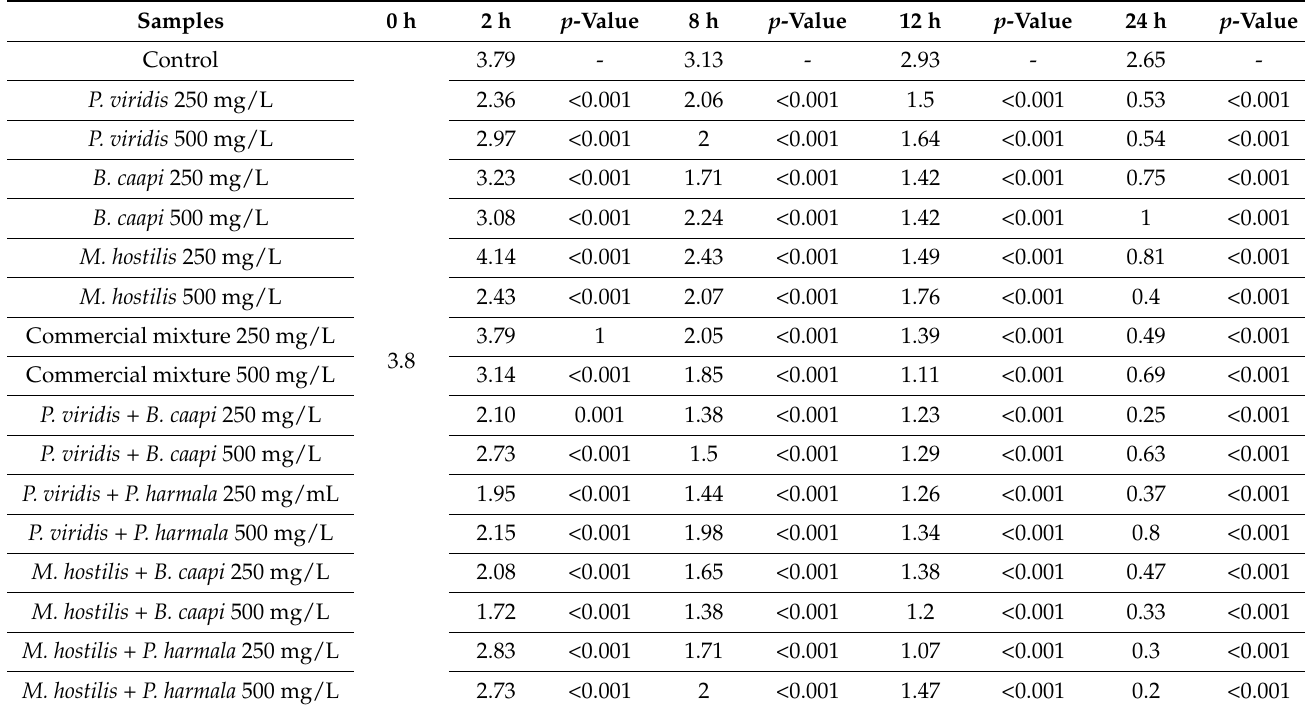
Table 3. Calculated mean difference between the distance of the injury of the negative control and the